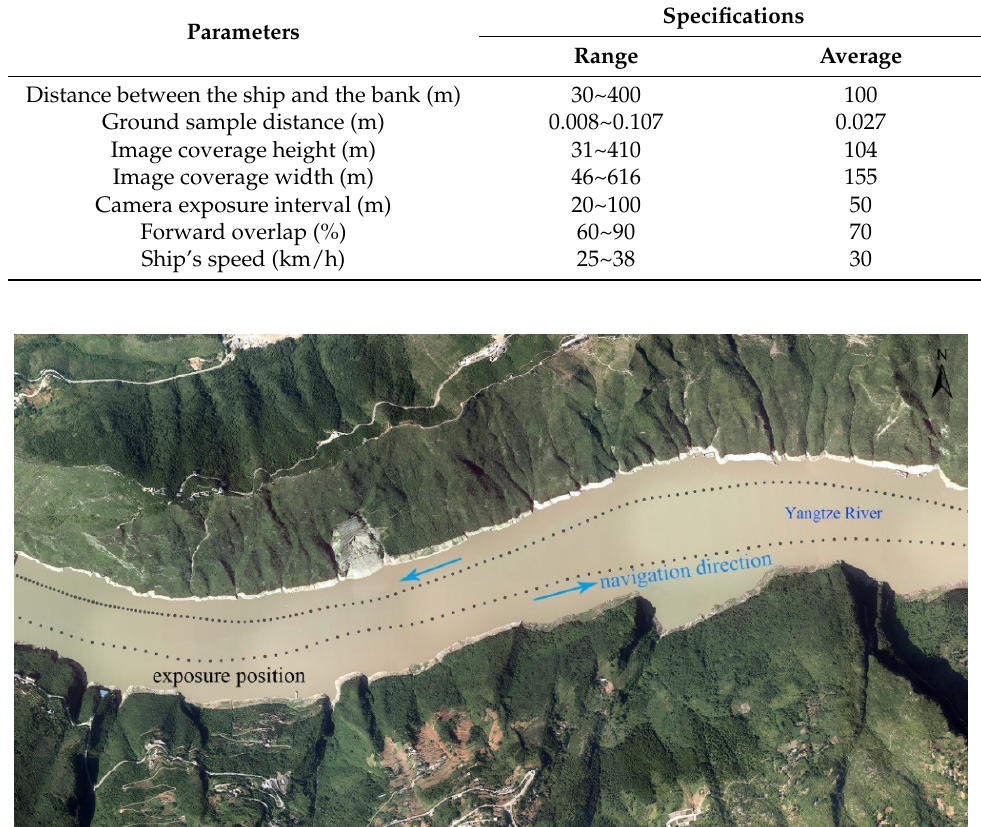
Figure 5. Schematic diagram of the distribution of camera exposure positions. The black dots indi- cate the camera exposure positions; each side of the bank was imaged